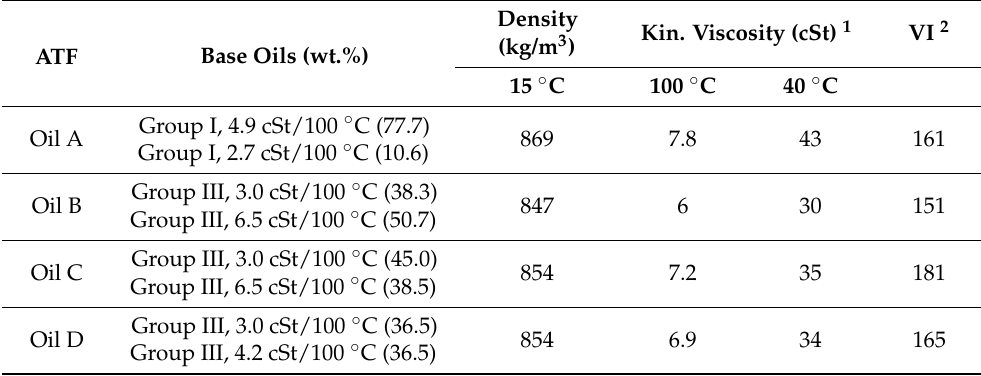
Table 1. Properties of the